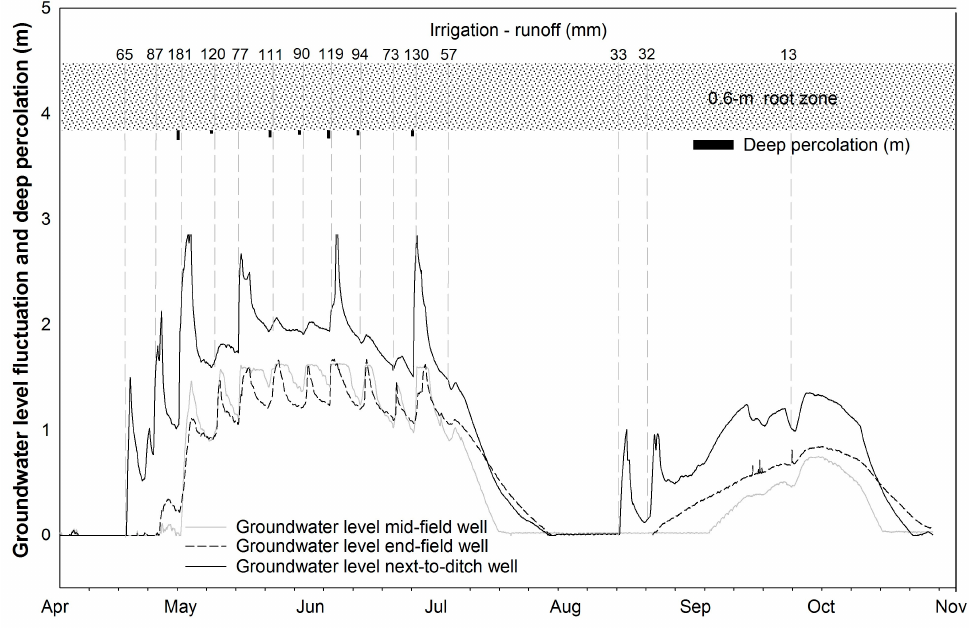
Figure 5. Irrigation water application, deep percolation, and shallow groundwater level fluctuations observed at the Rio Hondo study site.